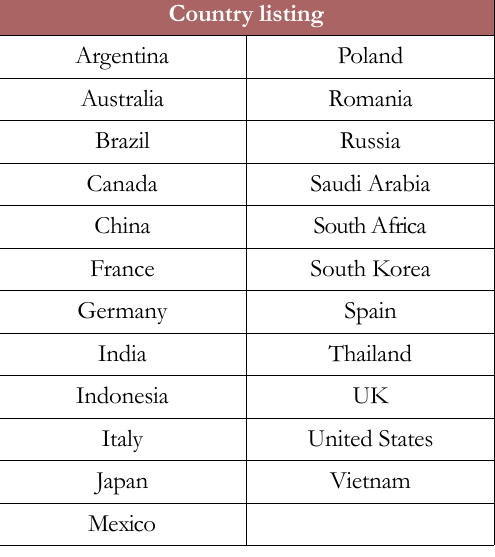
Table 2. Country